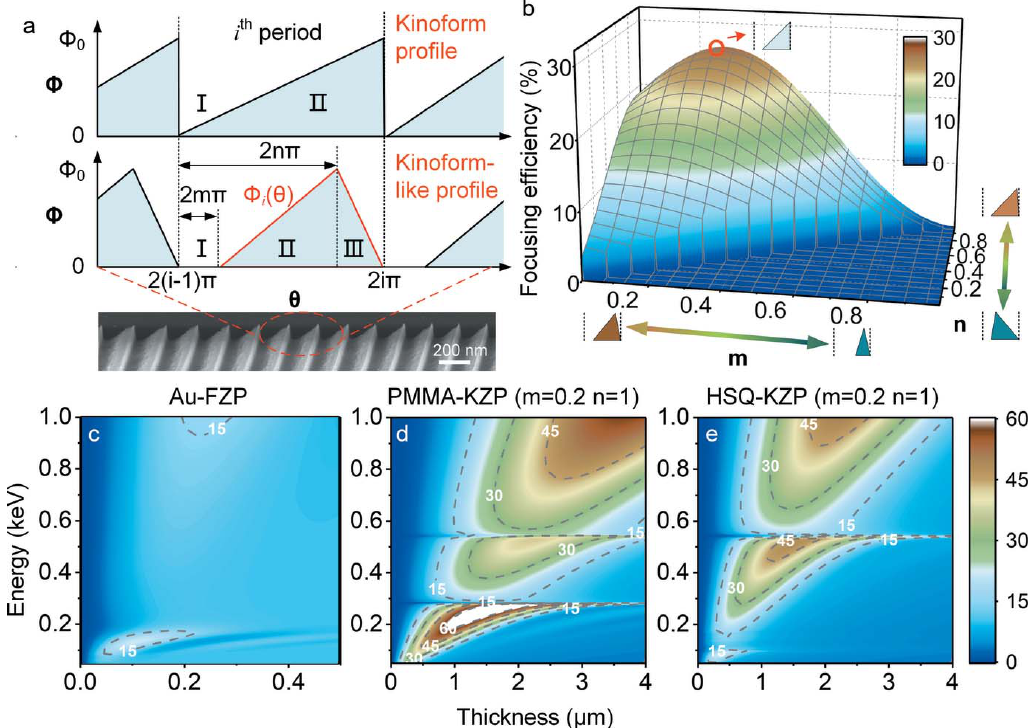
Figure 2 Theoretically calculated focusing efficiencies of kinoform zone plates suitable for GS-EBL for soft X-rays. ( a ) Illustrations of zone profile for KZPs. The thickness is shown in terms of the phase shift. An ideal kinoform lens has a vertical sidewall on one side; a fabricated kinoform zone plate, e.g. HSQ-KZP, has slopes on both sidewalls. Each zone of a real KZP is then divided into three regions with different transition function F ( (cid:6) ). m and n describe the relative position of the gap and the top of the KZP in the zone (0 < m < n < 1). ( b ) The calculated efficiency of the HSQ-KZP with thickness of 700 nm as a function of m and n at 500 eV, based on the thin grating approximation. ( c – e ) Theoretical calculations of the focusing efficiency of Au-FZP, PMMA- KZP ( m = 0.2, n = 1) and HSQ-KZP ( m = 0.2, n = 1) based on the thin grating approximation as a function of both the photon energy and the lens thickness in the soft X-ray region (0–1